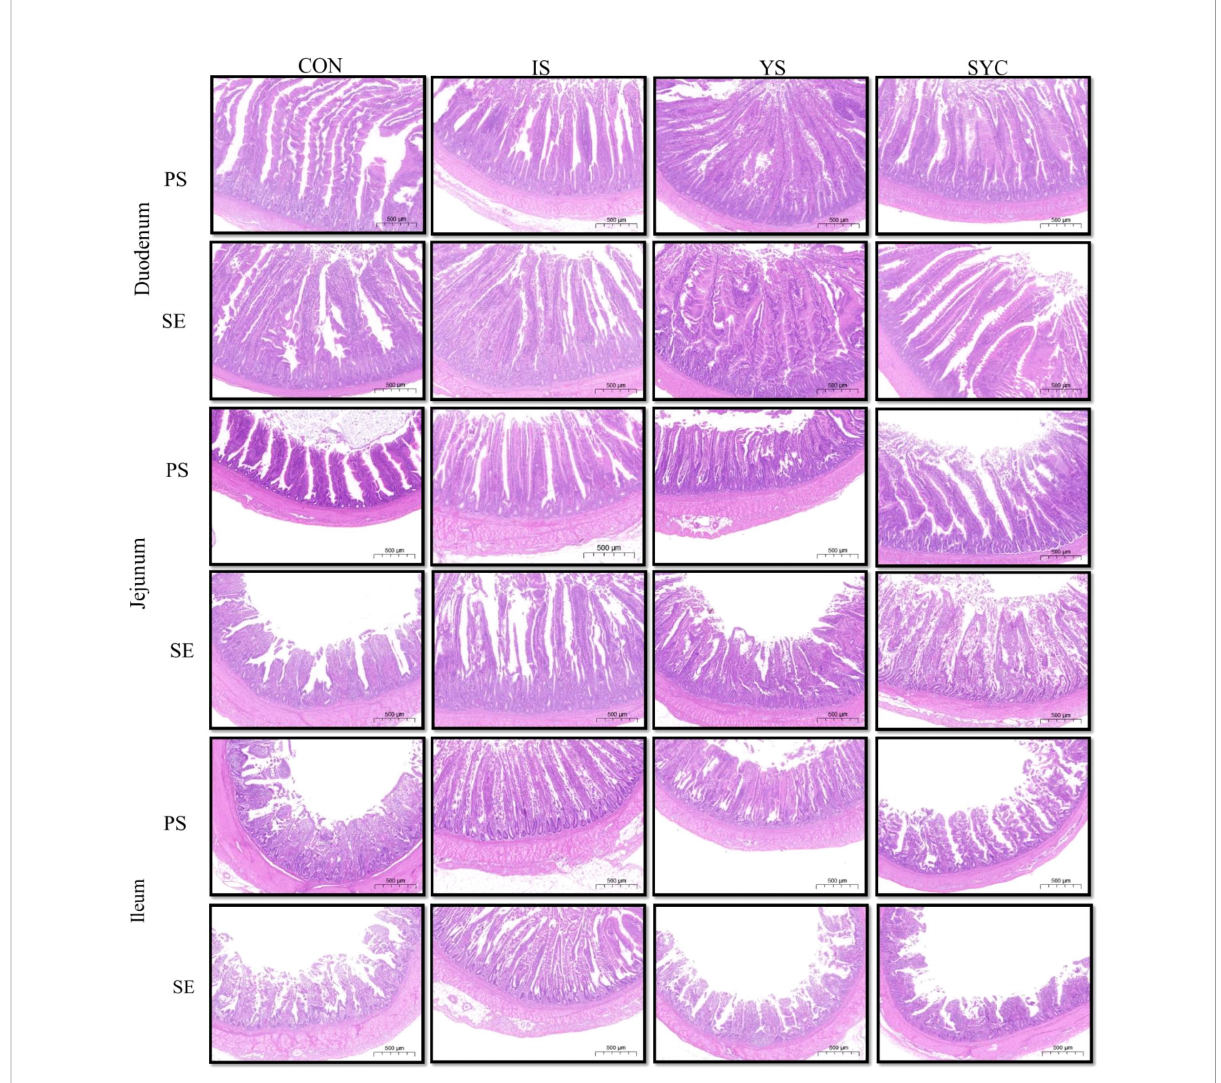
FIGURE 6 Effects of dietary supplementation with different Se sources on the small intestine histomorphology of laying hens challenged with S. Enteritidis. CON, basal diet; IS, sodium selenite; YS, yeast selenium; SYC, selenium-enriched yeast culture; PS, challenged with physiological saline solution; SE, challenged with S. Enteritidis . Hematoxylin and eosin staining of the duodenum, jejunum, and ileum of hens (bar = 500 m